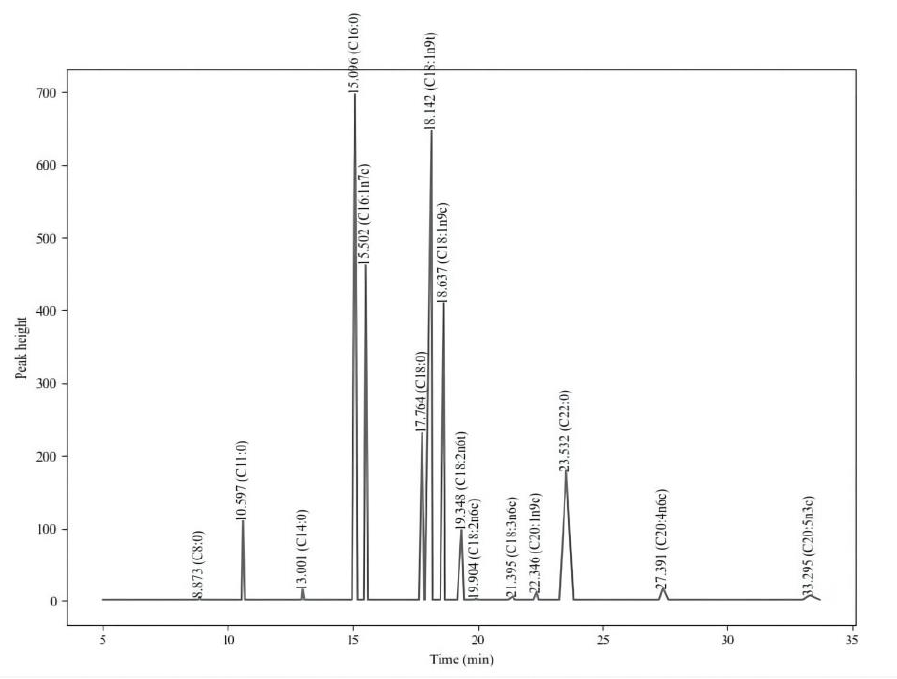
Figure 2. GC-MS total ion profile of a yolk sac sample.